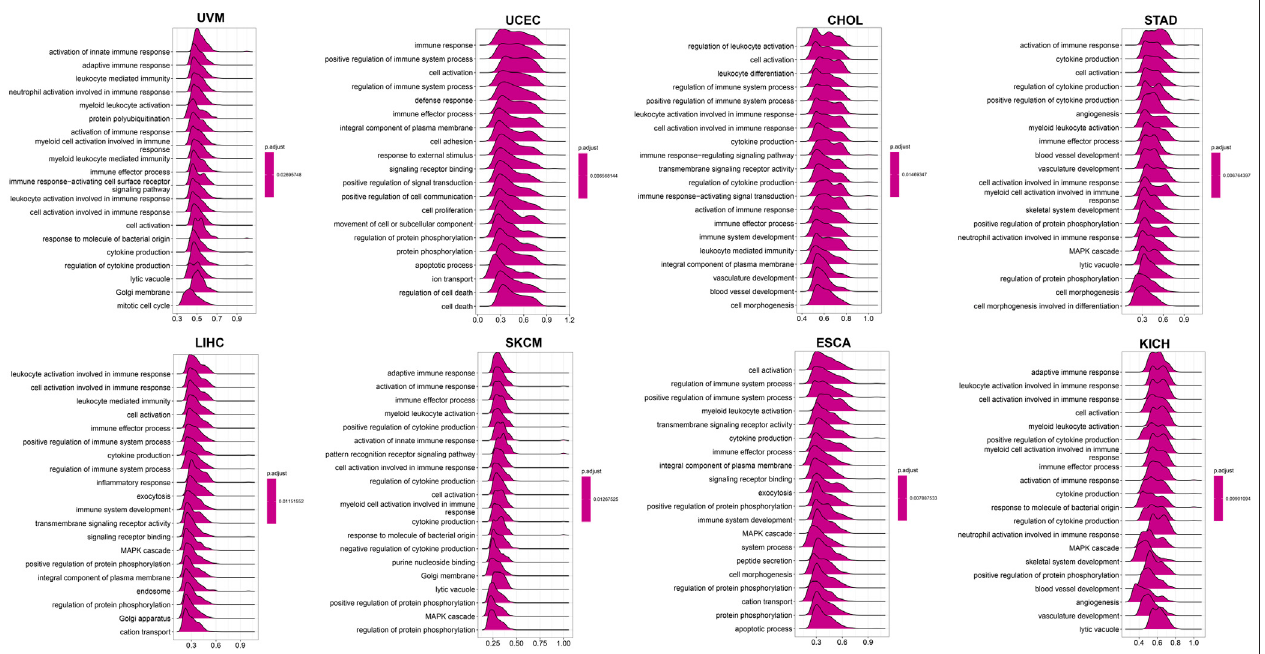
FIGURE 13 | GO annotations related to LY96 expression in uveal melanoma (UVM), uterine corpus endometrial carcinoma (UCEC), cholangiocarcinoma (CHOL), stomach adenocarcinoma (STAD), liver hepatocellular carcinoma (LIHC), skin cutaneous melanoma (SKCM), esophageal carcinoma (ESCA), and kidney chromophobe